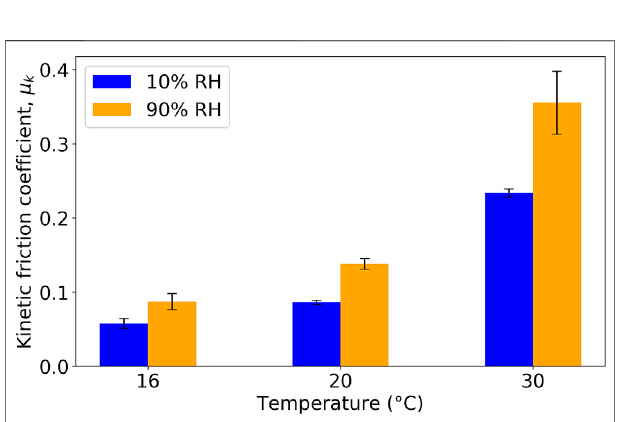
FIGURE 3 | Kinetic friction coef fi cient for L (XG) in a range of environmental conditions. Error bars indicate the standard deviation in μ k .